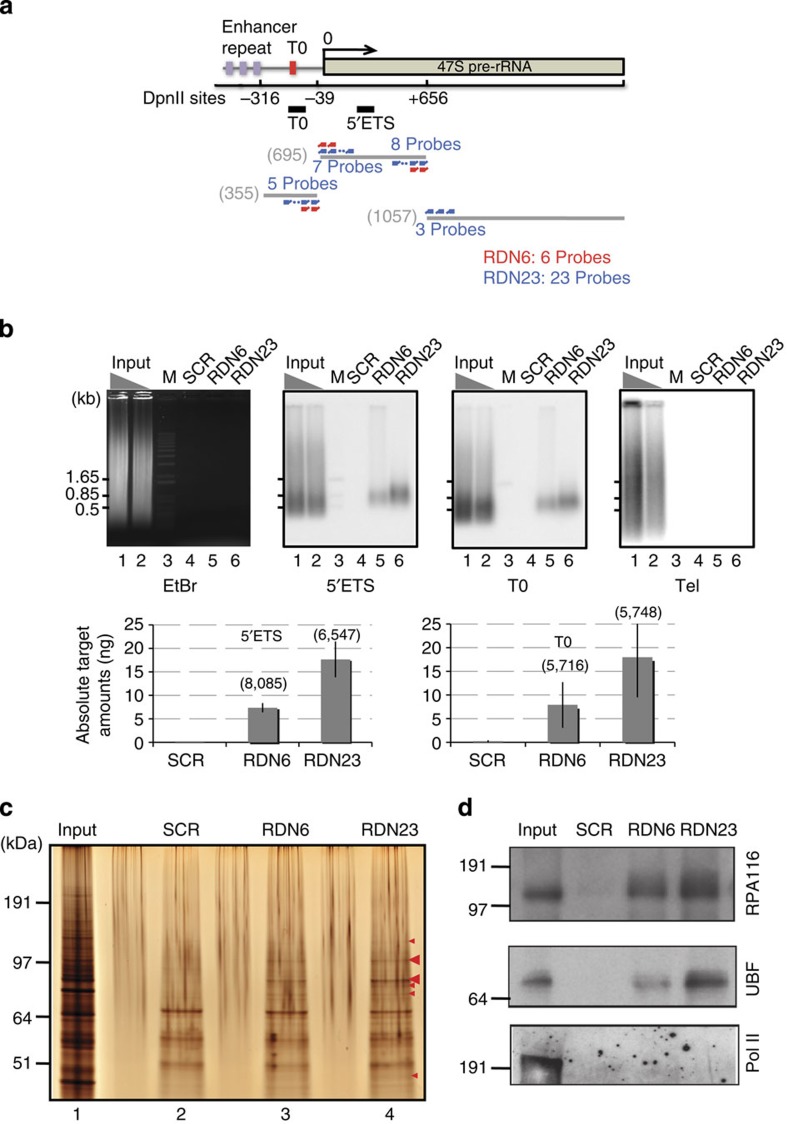
rDNA promoter chromatin purification.(a) The map of probe hybridization sites on the rDNA promoter region. An arrow: 47S pre-rRNA transcription initiation site. Scale bars (in bp) are shown below; 0 indicates the 5′ end of the pre-rRNA. Red bars: TTF-1-binding sites. Purple bars: repetitive enhancer elements are indicated. Black thick lines (T0 and 5′ETS) probes used in the Southern blots of b and Supplementary Fig. S2b. Grey lines: DpnII fragments from the promoter region. The probes that are designed to bind around DpnII sites are represented in red for ePICh with 6 probes (RDN6) and in blue for ePICh with 23 probes (RDN23). (b) DNA from ePICh material analysed by agarose gel electrophoresis. DNA was detected by EtBr staining (left panel) and quantified by Southern blotting with probes specific for the 5′ETS region, the TTF-1-binding site (see a) and telomere. Input represents 10 and 5% of the lanes 1 and 2 of the starting material. ePICh purified DNA using scrambled probe (lane 4), RDN6 probe (lane 5) and RDN23 probe (lane 6) were analysed. Bottom bar graph, absolute quantification of rDNA amount in ePICh material. The signal of the materials from ePICh with each probe were compared with a standard plasmid DNA containing the DpnII fragment from 5′ETS and the DpnII fragment from T0 shown in a. The numbers above the graph bars represent the relative enrichment of the analysed rDNA fragments compared with major satellites, as measured by real-time PCR. (c) Silver staining of proteins obtained from ePICh with scrambled, RDN6 and RDN23 probe sets in mouse erythrocytes leukaemia (MEL) cells. 10% of the ePICh material was analysed. Red arrowheads show specific bands detected using RDN6 and RDN23 probes. (d) Western blot analysis monitoring ePICh enrichment. The second biggest subunit of RNA polymerase I (RPA116) and UBF in materials from ePICh with each probe set were assayed. As a negative control for background enrichment, the RNA Polymerase II RPB1 subunit was probed. Input represents 0.0004% of the chromatin extracts. 5% of the ePICh material were loaded per lane.